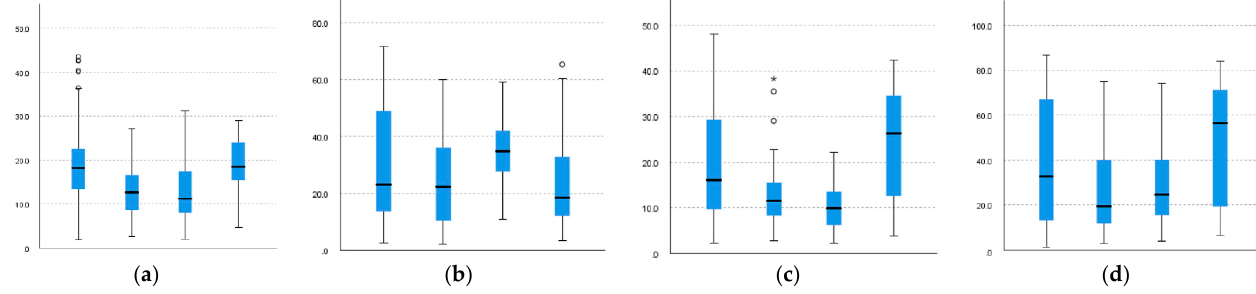
Figure 8. Comparison of upper-body joint angle variation. ( a ) VRelbow. ( b ) VRwrist. ( c ) VLelbow. ( d ) VLwrist. Table 7. Post hoc testing of upper-body joints.